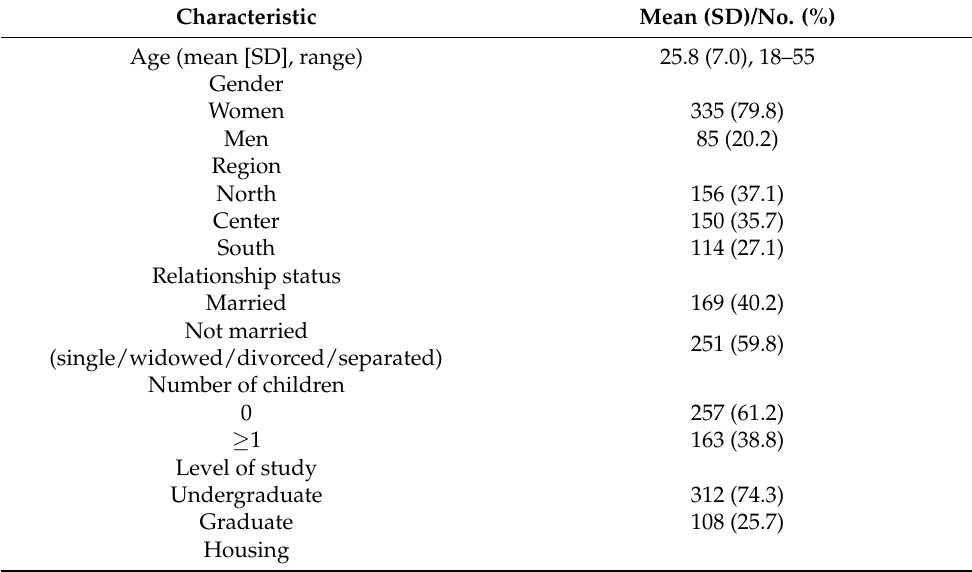
Table 1. Sociodemographic, academic, and health characteristics ( n =